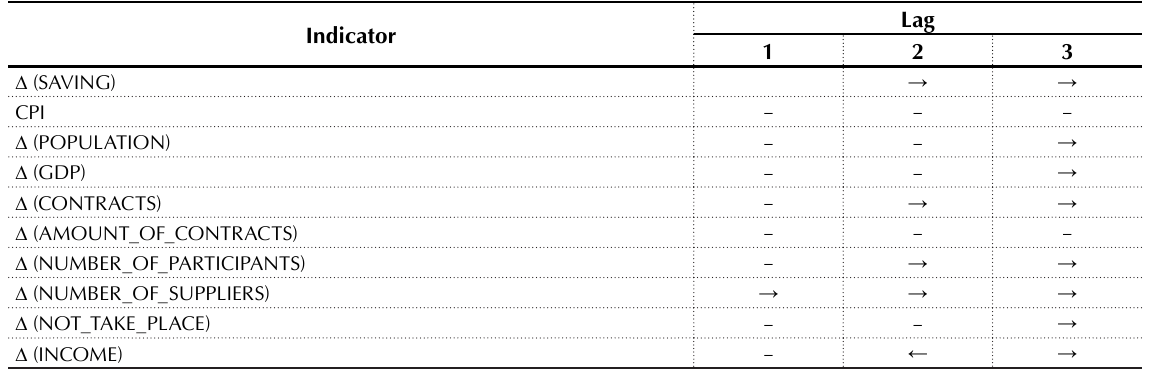
Table 5. Granger causality study for the indicator of saving public procurement (in the first differences)